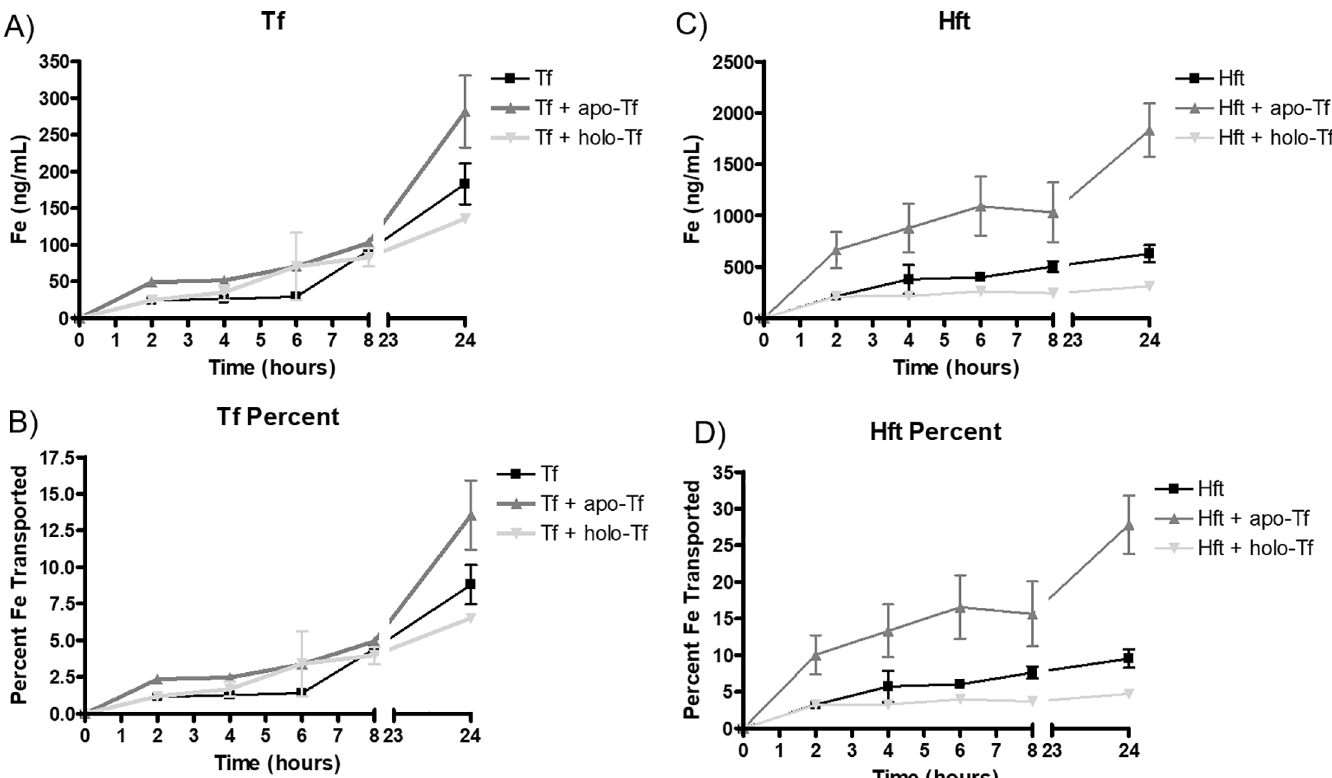
Fig 2. Transferrin and H-ferritin transport of iron is responsive to signaling by apo- and holo-Tf. A) Apo-Tf in the basal chamber increases the amount of iron transported across the endothelial cells by transferrin whereas holo-Tf decreases the amount transported. The control condition is the basal media with no extra addition. B) Here, the data from panel A are shown as a percent of control. C) Apo-Tf in the basal chamber significantly increases the amount of iron transported by H- ferritin while holo-Tf decreases the amount transported relative to control. D) H-ferritin transport of iron from panel C as a percent of control conditions. All values are means ± SD, with statistical significance evaluated against the control (addition of Tf or Hft alone) using two-way ANOVA and Bonferroni’s post hoc comparisons. (cid:3) = p < 0.05, (cid:3)(cid:3)(cid:3) = p < 0.001.